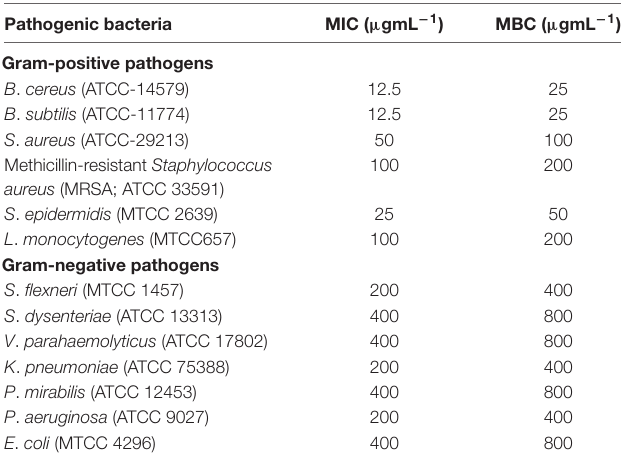
TABLE 1 | Antibacterial activity-minimum inhibitory concentrations (MIC- µ g ml − 1 ) and minimum bactericidal concentrations (MBC- µ g ml − 1 ) of EA (ethyl-acetate) culture extract of HelS1 against pathogenic